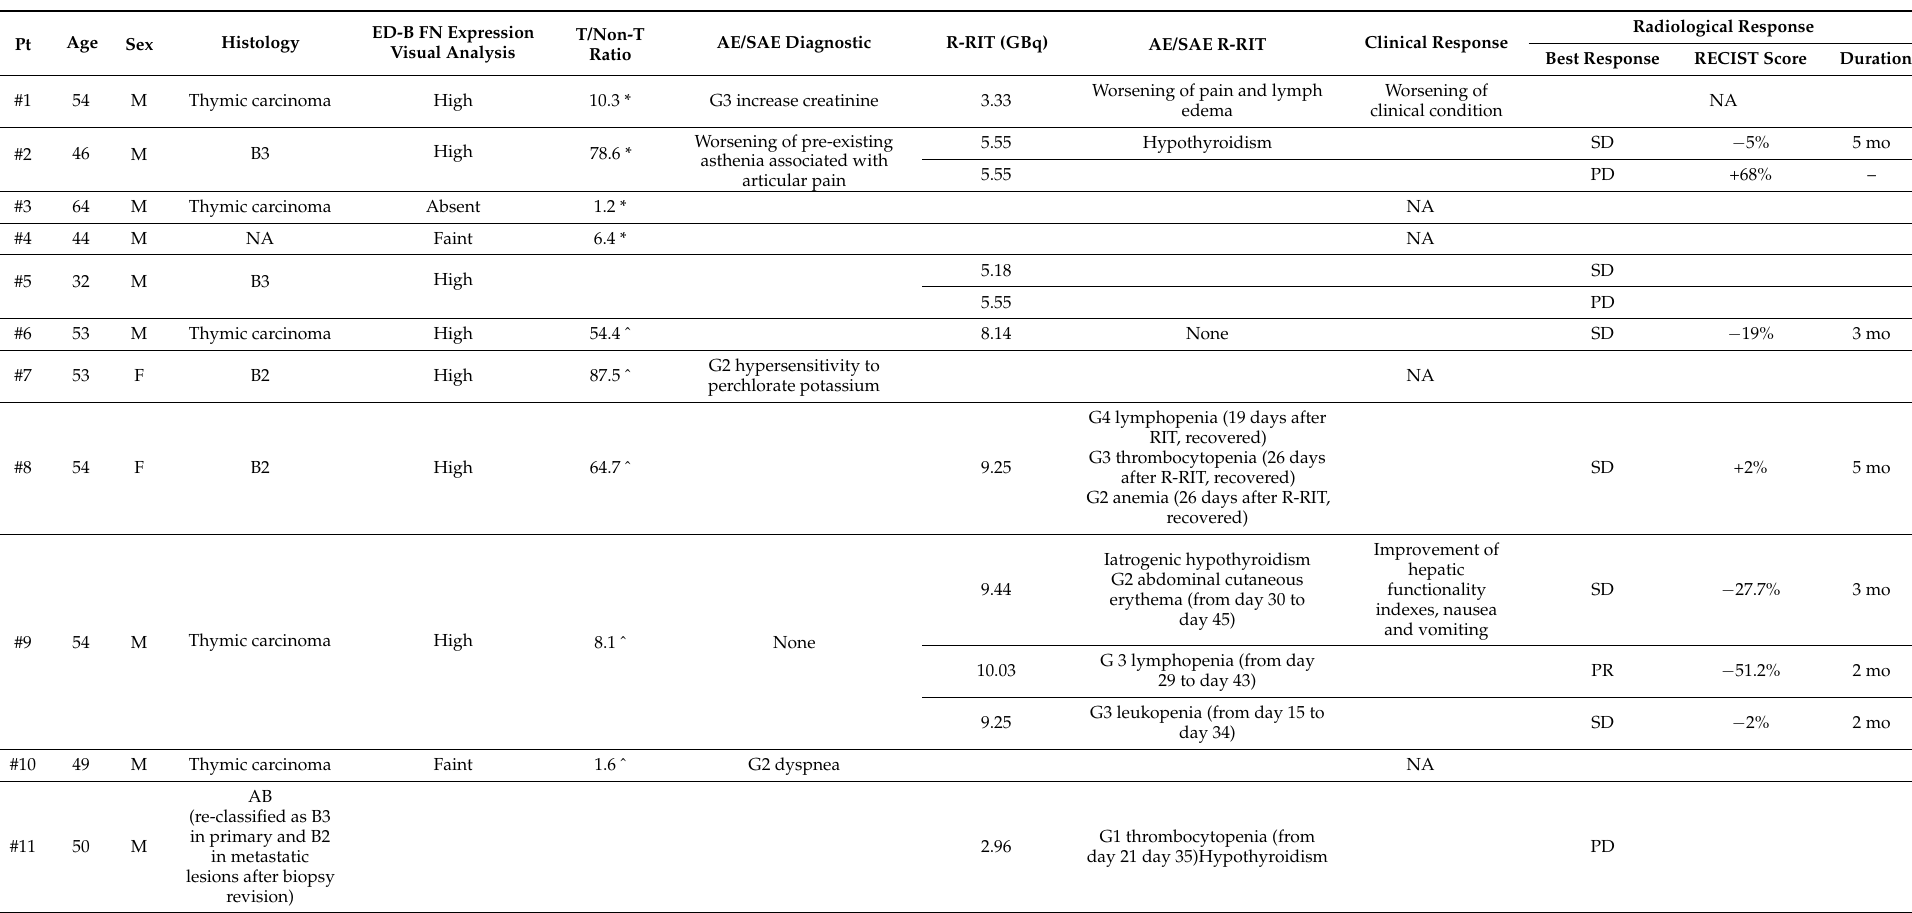
Table 1. Main characteristics and results for each